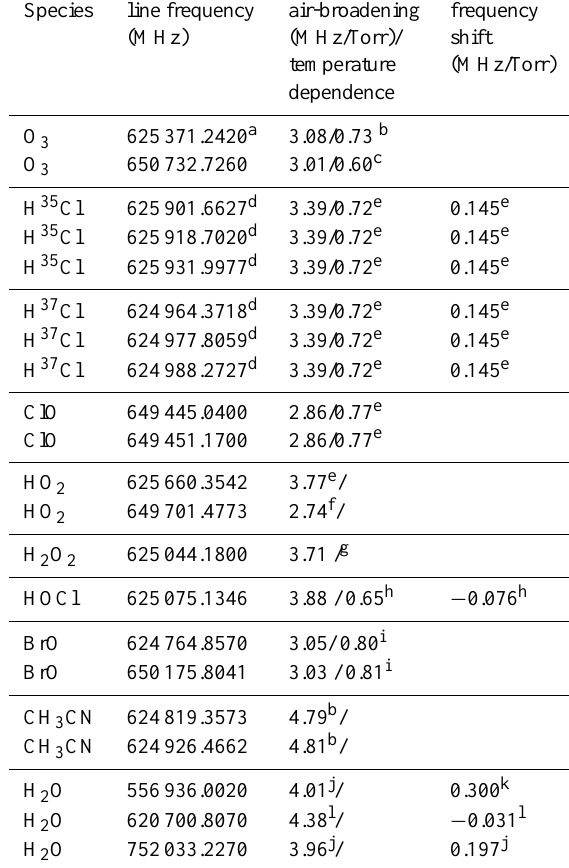
Table 3. Values of the line frequency and of the air-broadening and pressure induced frequency shift parameters measured in labora- tory. Only the main lines used in the processing are shown. Values not indicated are taken from the HITRAN (2008)